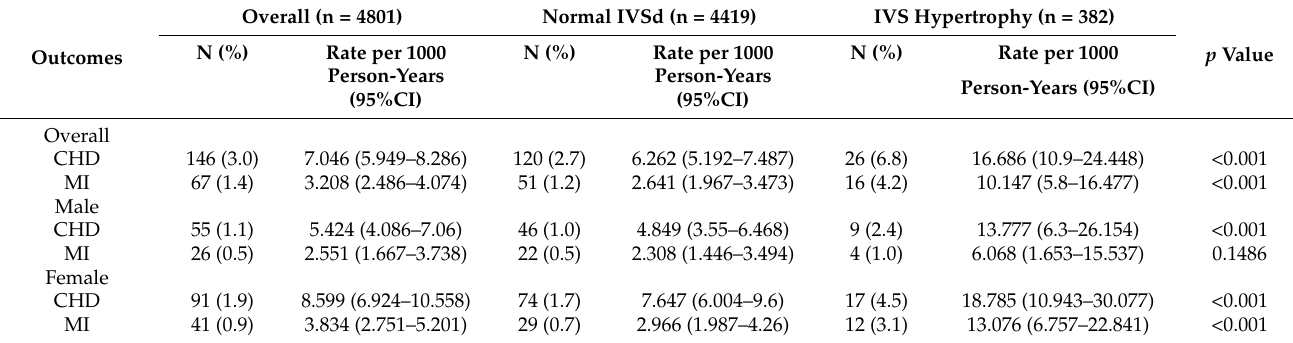
Table 2. Incidences of CHD and MI in study